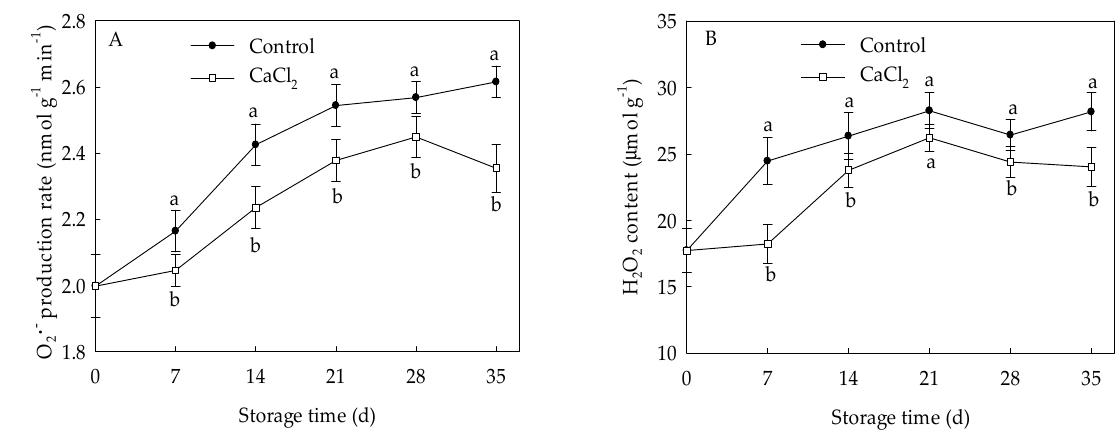
Figure 2. O (cid:2870)•(cid:2879) generation rate ( A ) and H 2 O 2 content ( B ) in loquat fruit stored at 1 °C after treatment with 1% CaCl 2 or water (control). Vertical bars indicate the SE of mean ( n = 3). The symbols a and b represent a significant difference in the two treatments ( p < 0.05).